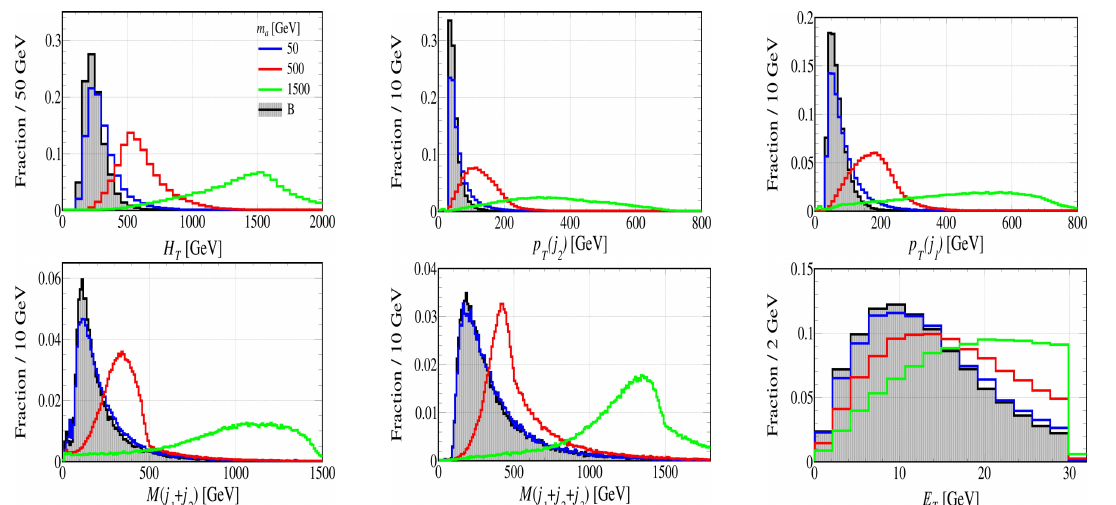
Figure 10 . Distributions of observables for the signal with benchmark coupling C ˜ 10 − 2 TeV − 1 and representative ALP masses, and for the total SM